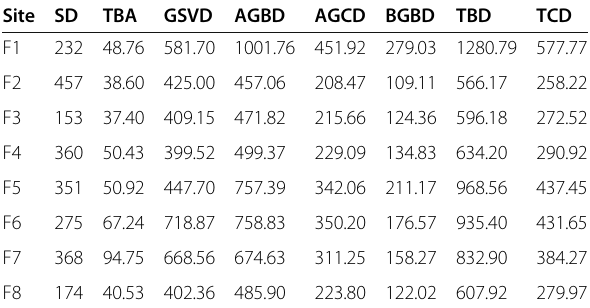
Table 4 Tree parameters, growing stock, biomass, and carbon stock for forest types